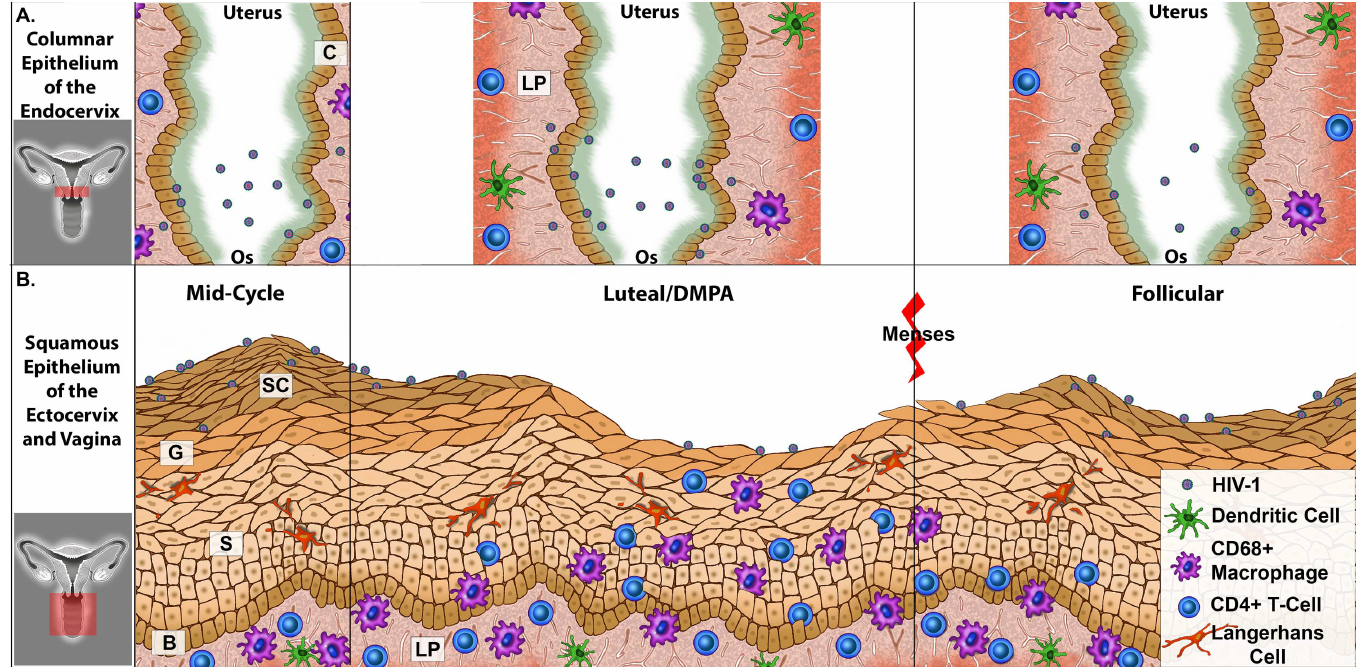
Fig 5. Mechanistic Modelof How HIV-1 Interactswiththe FemaleReproductive Tract duringVarious Phases of the MenstrualCycle and/orwiththe use of DMPA. (a).The simplecolumnarepitheliumof the endocervix:(Left)as mid-cycle progressesinto luteal phase, a small numberof virionsare able to enterthe cervicalcanal to associate with the simplecolumnarepitheliumof the endocervix. (Middle) Duringthe lutealphase and/orwith the use of progesterone contraceptives (e.g., DMPA), virionsare morereadilyable to enterthe cervicalcanal to interactwith the simplecolumnarepitheliumof the endocervix.(Right)Duringthe follicular phase, virionsrarely enterthe cervicalcanal to interactwith the endocervicalsimplecolumnar. Tissue layers are labeledas follows: C = simplecolumnar, LP = laminapropria.(b).The stratifiedsquamous epithelium of the ectocervixand vagina: (Left)At the midcycle phase, the squamous epithelium is thickest and virionsmay penetrate the non-viable stratumcorneum.However, targetcells are primarilylocatedbelow the epidermis,in the laminapropria;therefore, the likelihood of virusinteracting with a targetcell is minimal.(Middle) Althoughfew virionsare visualized penetratingthe stratifiedsquamous epitheliumdue to the lack of stratumcorneumduringthe lutealphase (or with exogenous progesterone treatments;e.g., DMPA), thereis a greaterpropensityfor virusto interactwith an infiltratingintraepithelial targetcell near the luminalsurface. (Right)Like the mid-cycle phase, the squamous epithelium duringthe follicular phase is thick, and virionsare associated with the non-viablestratumcorneum.However, targetcells are primarilylocatedbelow the epidermis, in the laminapropria;therefore, the likelihood of virusinteracting with a targetcell is minimal.Tissue layers are labeledas follows: SC = stratumcorneum,G = granulosum, S = spinosum,and B = basal layer, LP = laminapropria.